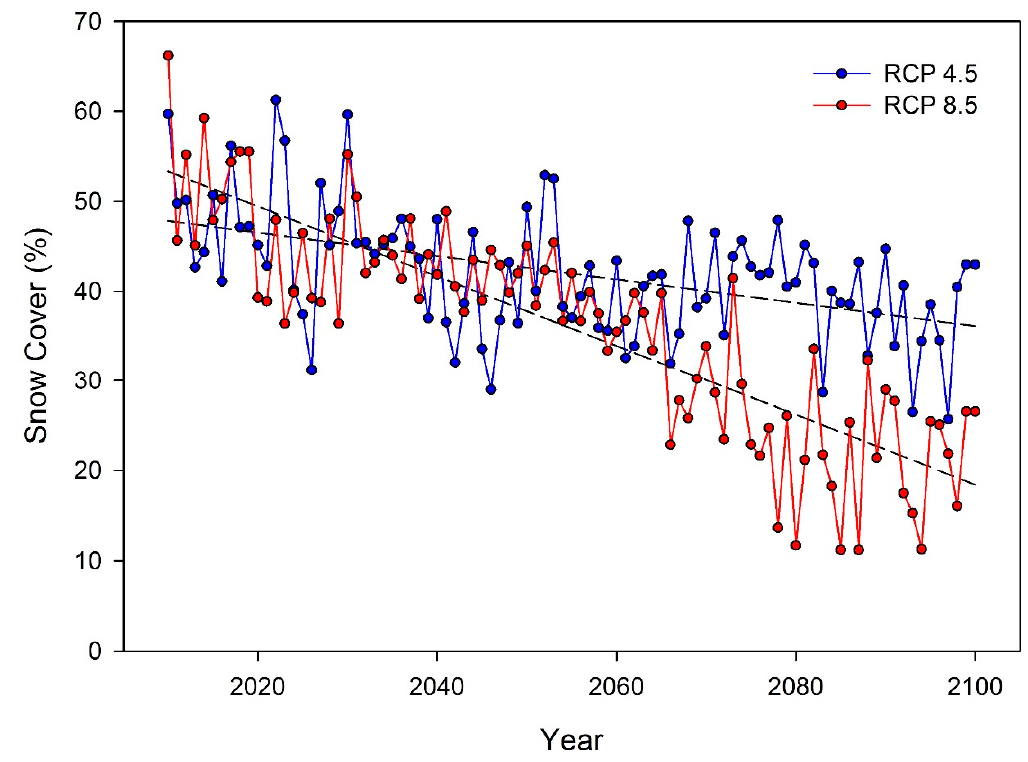
Figure 10. The trend of yearly projected average snow cover under RCP4.5 and RCP8.5 climate change scenarios for the Astore River.